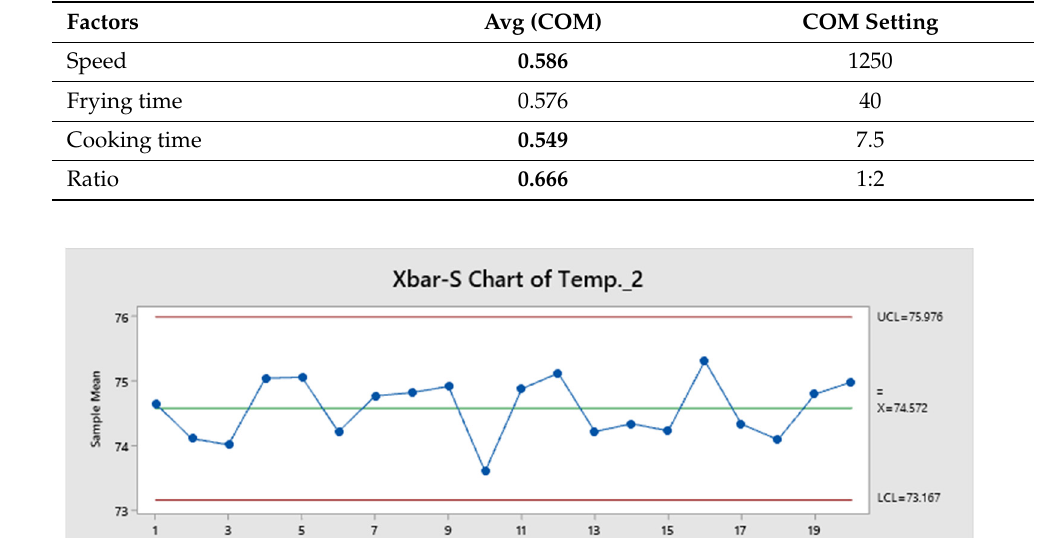
Table 17. Results for the optimization of the multi-response problem. Table 15. Samples for temperature response after applying the optimization method.